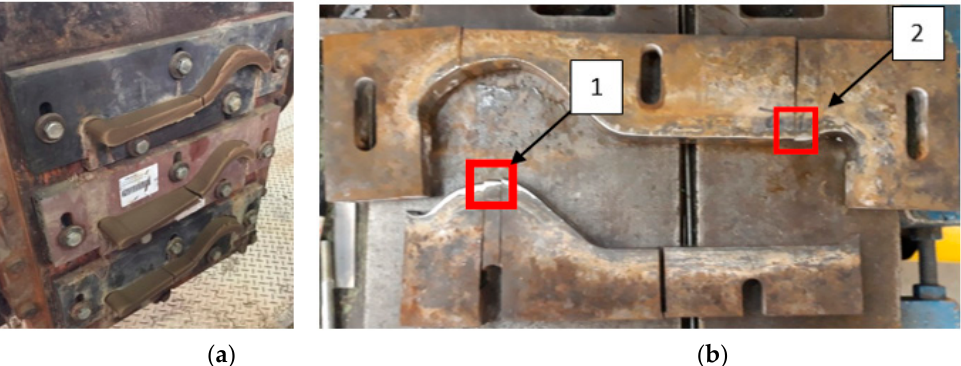
Figure 1. Photographs of: ( a ) inserts forming the clay band during operation; ( b ) upper and lower tools with marked areas from where test samples made of steel NC11LV were collected.